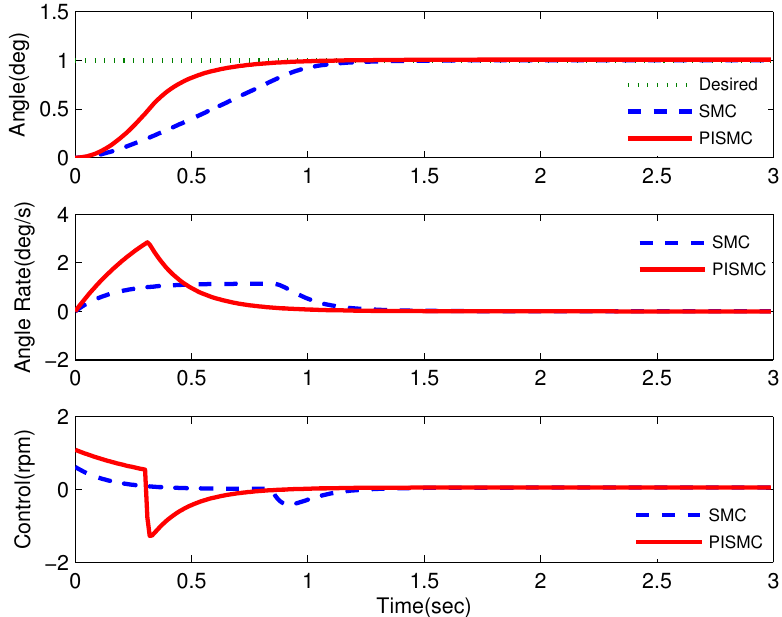
Figure 10. Balance response to PISMC without disturbances: ( top ) angular response; ( middle ) response of angular rate; ( bottom ) applied control